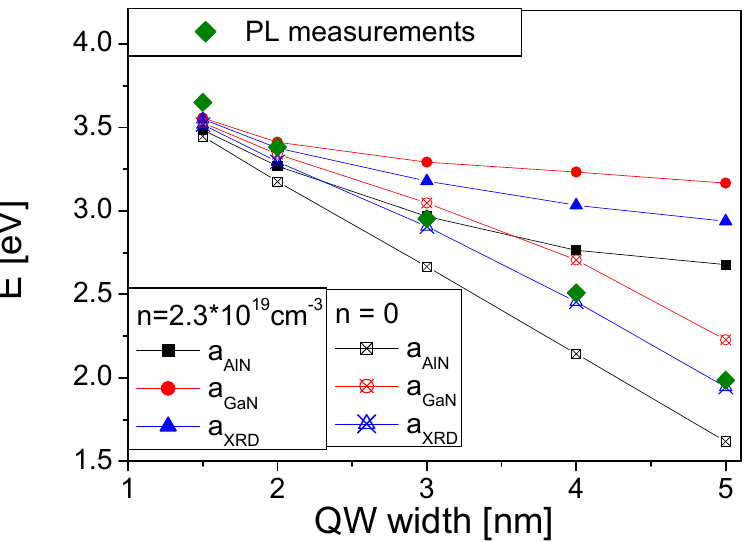
Figure 9. Comparison of the PL measurements of optical transition in various width GaN/AlN MQWs and the ab-initio-determined band-to-band transition energies.